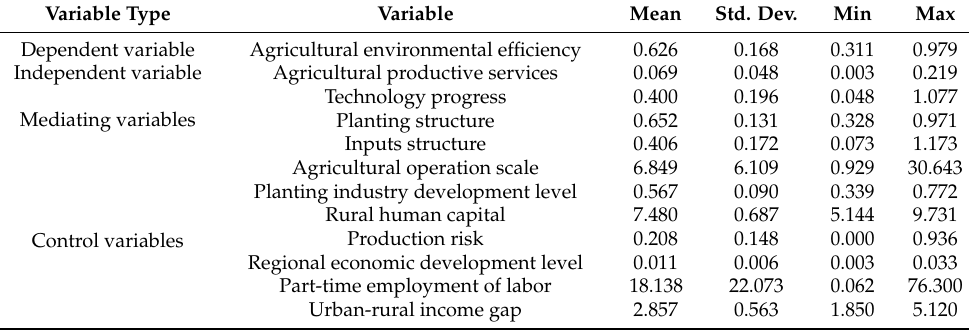
Table 2. Descriptive statistics on